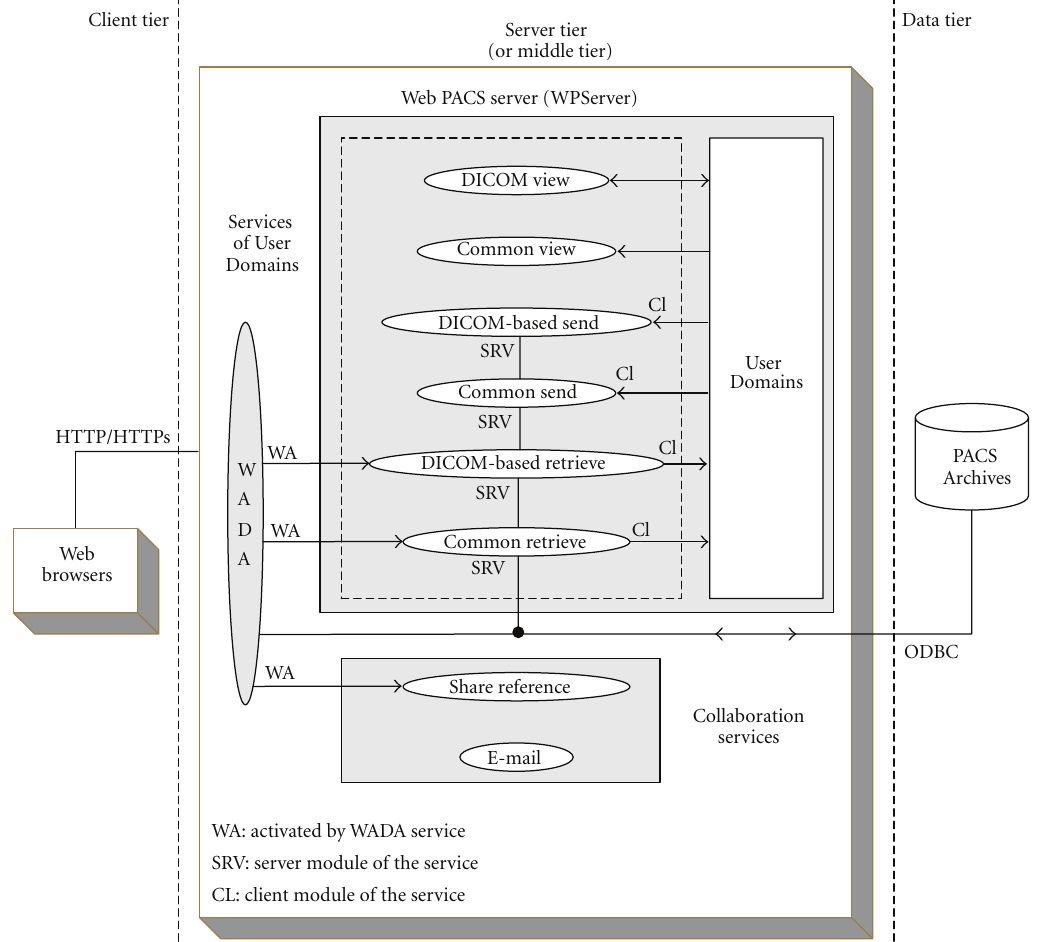
Figure 1: The three-tier multiprotocol architecture of the new teleradiology